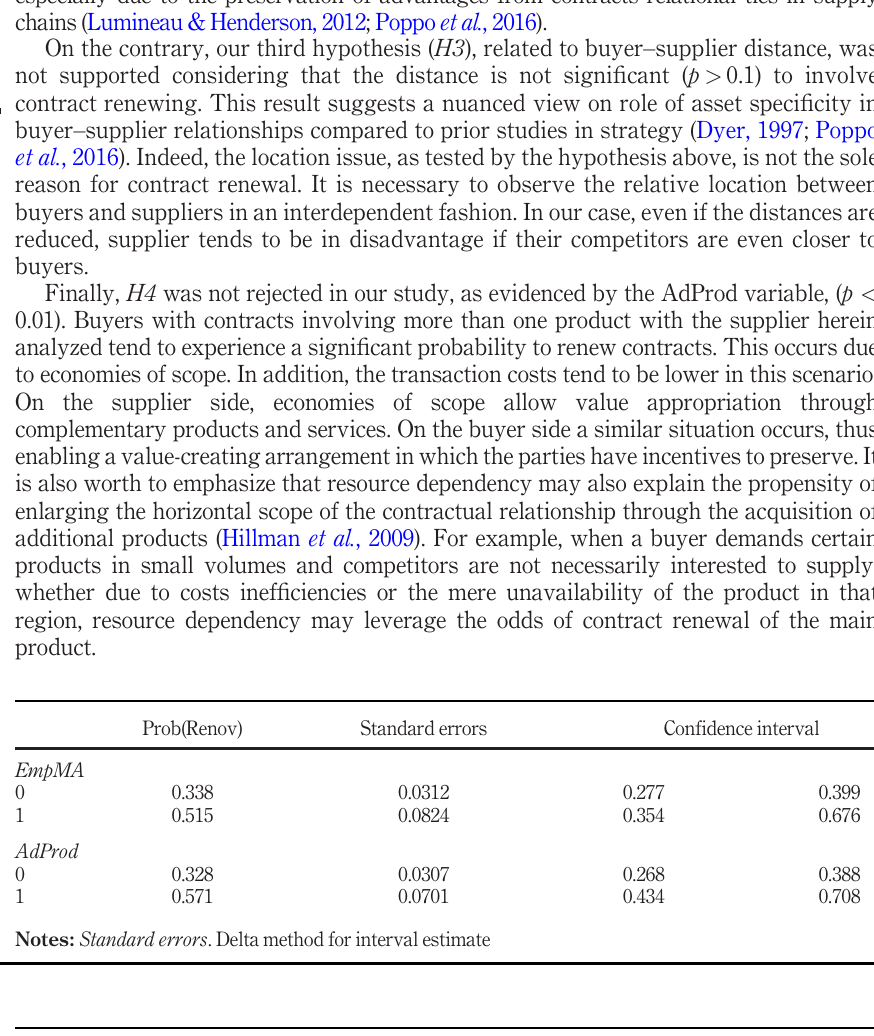
Classified Renov =